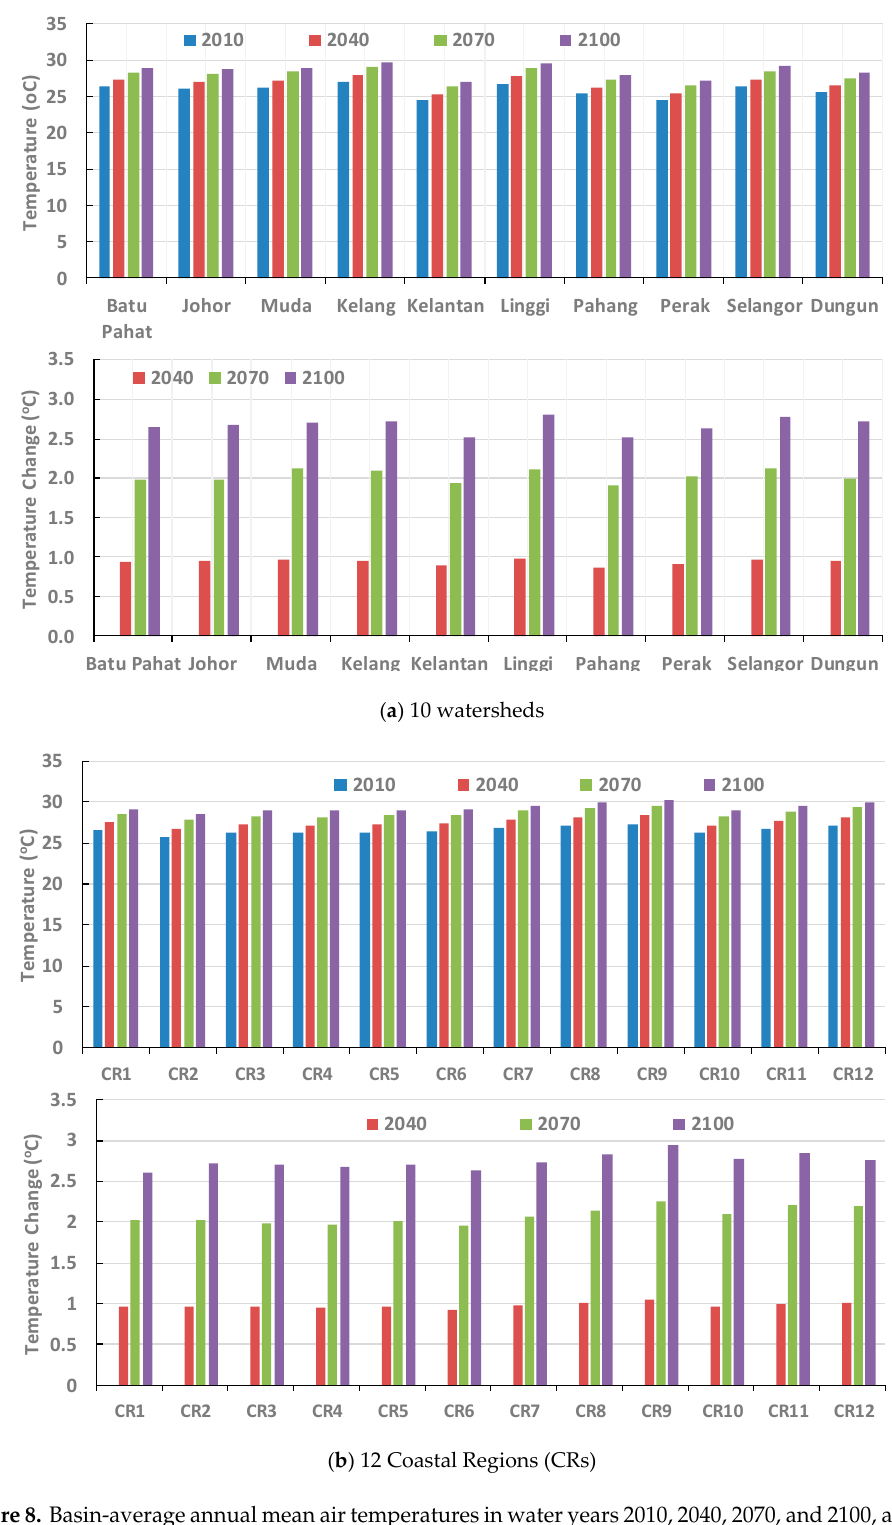
Figure 8. Basin-average annual mean air temperatures in water years 2010, 2040, 2070, and 2100, and the change in annual mean air temperature from water year 2010 to water years 2040, 2070, and 2100 in Peninsular Malaysia. ( a ) 10 watersheds; ( b ) 12 Coastal Regions